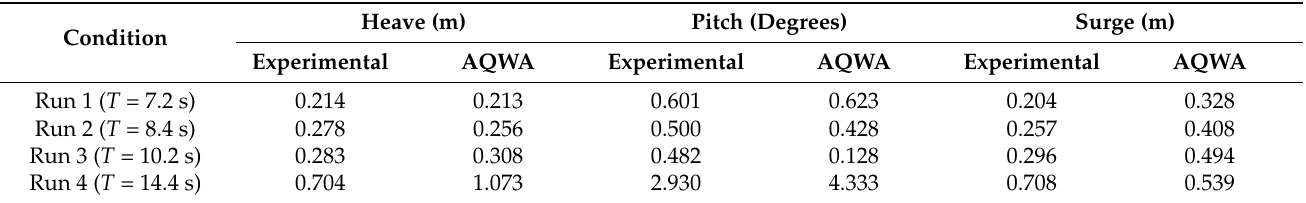
Table 5. Comparison between experimental and numerical results for heave, pitch, and surge response in regular waves for H = 1.404 m.